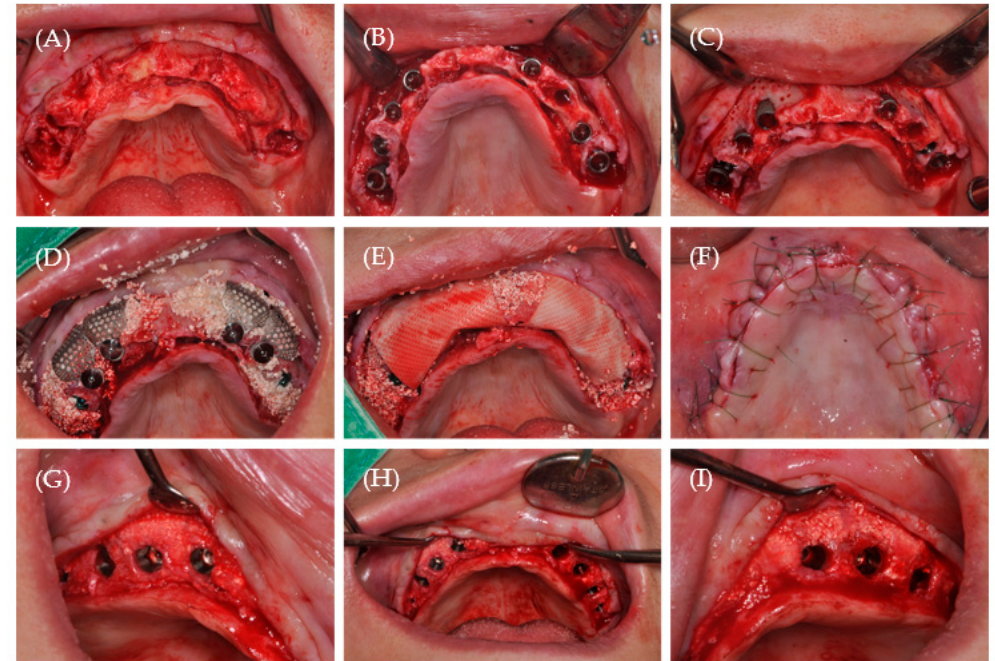
Figure 1. Surgical procedure. ( A ) Flap elevation, ( B , C ) Implantation, ( D ) Bone grafts and 3-D preformed titanium mesh application, ( E ) Collagen membrane application, ( F ) Suturing, and ( G – I ) Secondary implant surgery.